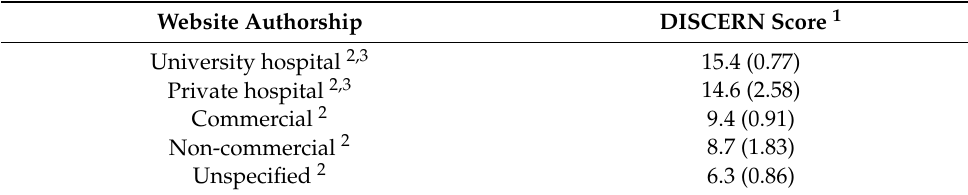
Table 5. DISCERN scores by website authors.